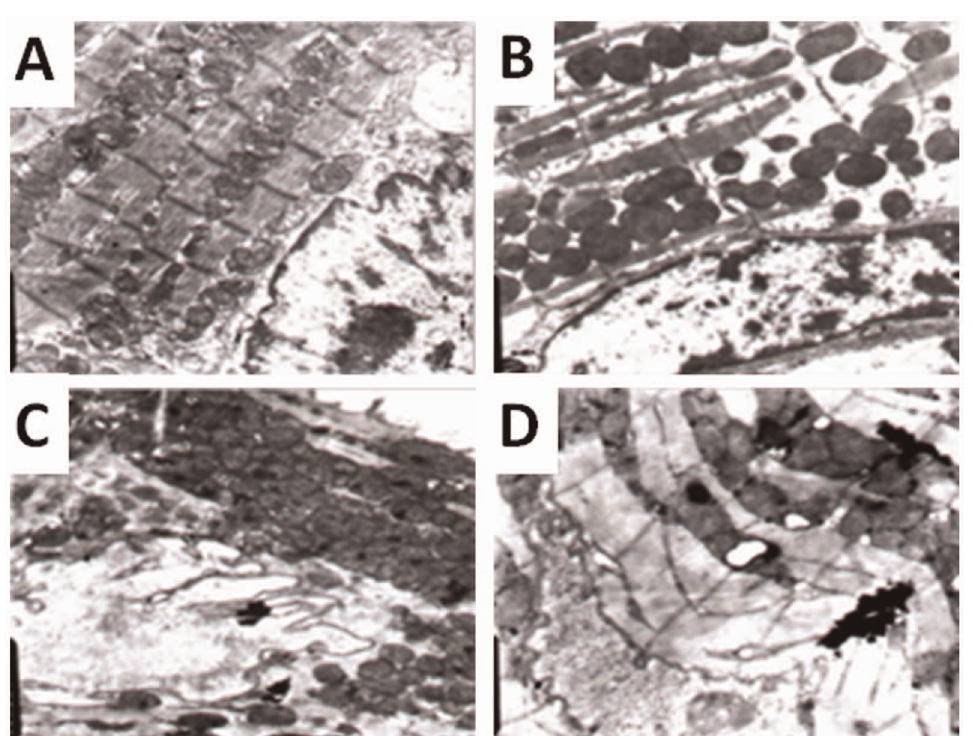
Fig. 5. The structure of mitochondria in cardiomyocyte of VMC mice (magnification 10,000X). ( a ) Cardiomyocyte of normal mouse. The mitochondria were circle or elliptical with legible and densely packed cristae. There were also sporadic glycogen granules between the myofibrils. ( b ) Cardiomyocyte of mice 3 days after virus infection. The mitochondria proliferated and swelled, with pyknosis, vesicle and the decreased matrix; glycogen granule decreased or disappeared. ( c ) Cardiomyocyte of mice 11 days after virus infection. The mitochondria proliferated and swelled, with the fusion of mitochondrial membrane and merged to huge mitochondria; glycogen granule decreased; inhomogeneous myofibril dissolved, and the sarcomere disappeared. ( d ) Cardiomyocyte of mice 24 days after virus infection. The mitochondria significantly proliferated and swelled, the cristae became vague; glycogen granule decreased, and sarcoplasmic reticulum dilated.